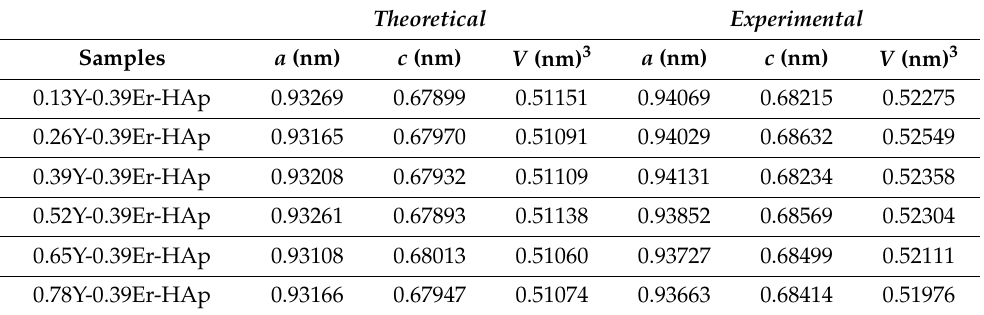
Table 2. The comparison of theoretical and experimental values of the lattice parameter and unit cell volume.